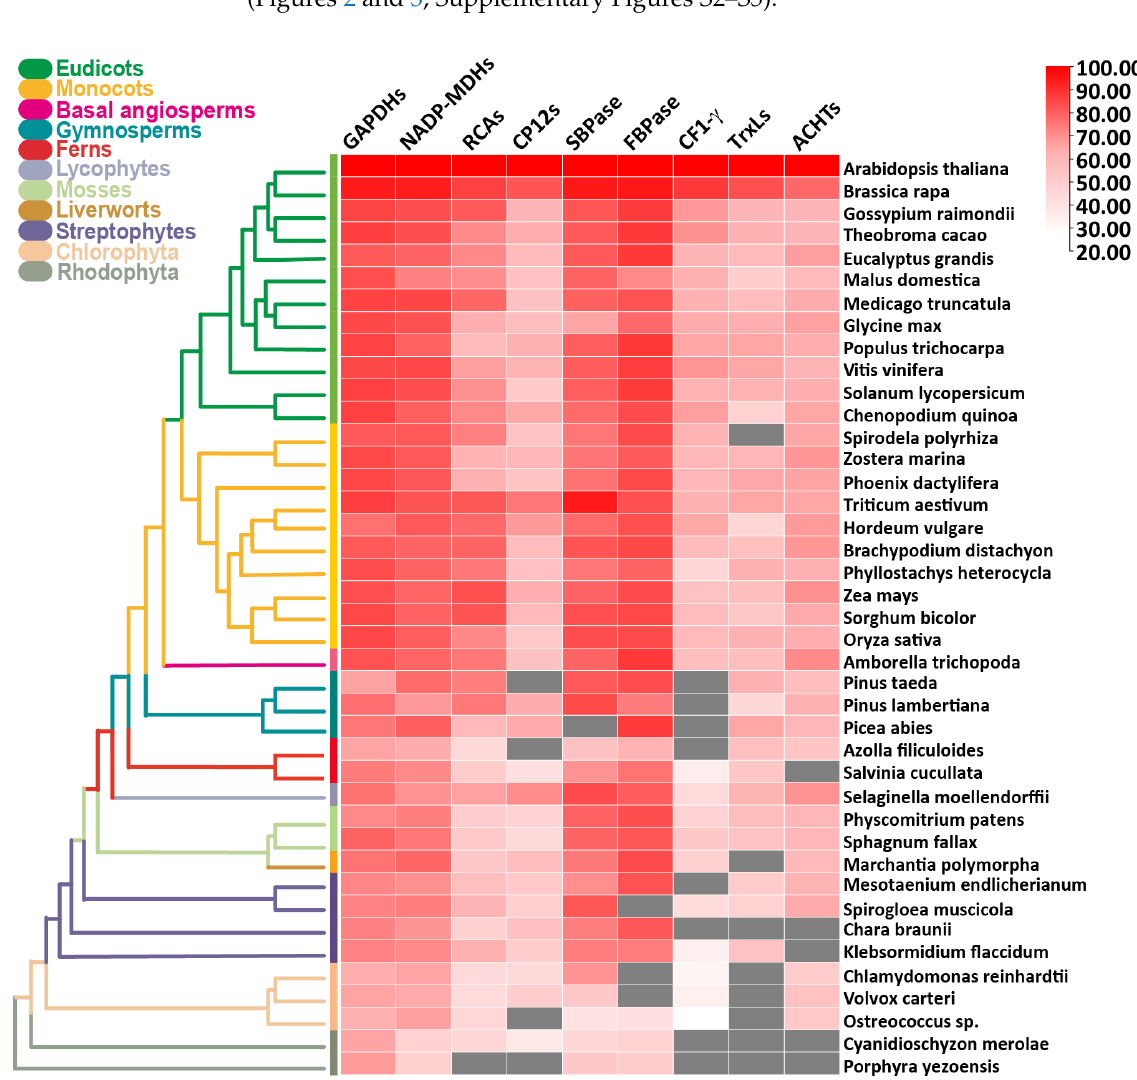
Figure 2. Comparative molecular evolution of key photosynthetic redox regulators and photosynthesis protein families in algae and land plants candidate proteins were extracted using BLASTP (NCBI), and the all-against-all BLASTP search with satisfied E-value of 10 − 10 and query coverage of 50%. Heat map was generated using TBtools [85] from the data of seven photosynthesis-related proteins and four redox-related families. Black squares indicate the proteins that do not satisfy the selection criteria. ACHTs: atypical Cys His-rich, CF1-y: gamma subunit of ATP synthase; CP12; FBPase: fructose-1,6-bisphosphatase; GADPH: glyceraldehyde-3-phosphate dehydrogenase; NADP-MDH: NADP + dependent malate dehydrogenase; RCA: ribulose-1,5-bisphosphate carboxylase/oxygenase activase; SBPase: sedoheptulose-1,7-bisphosphatase; TrxLs: